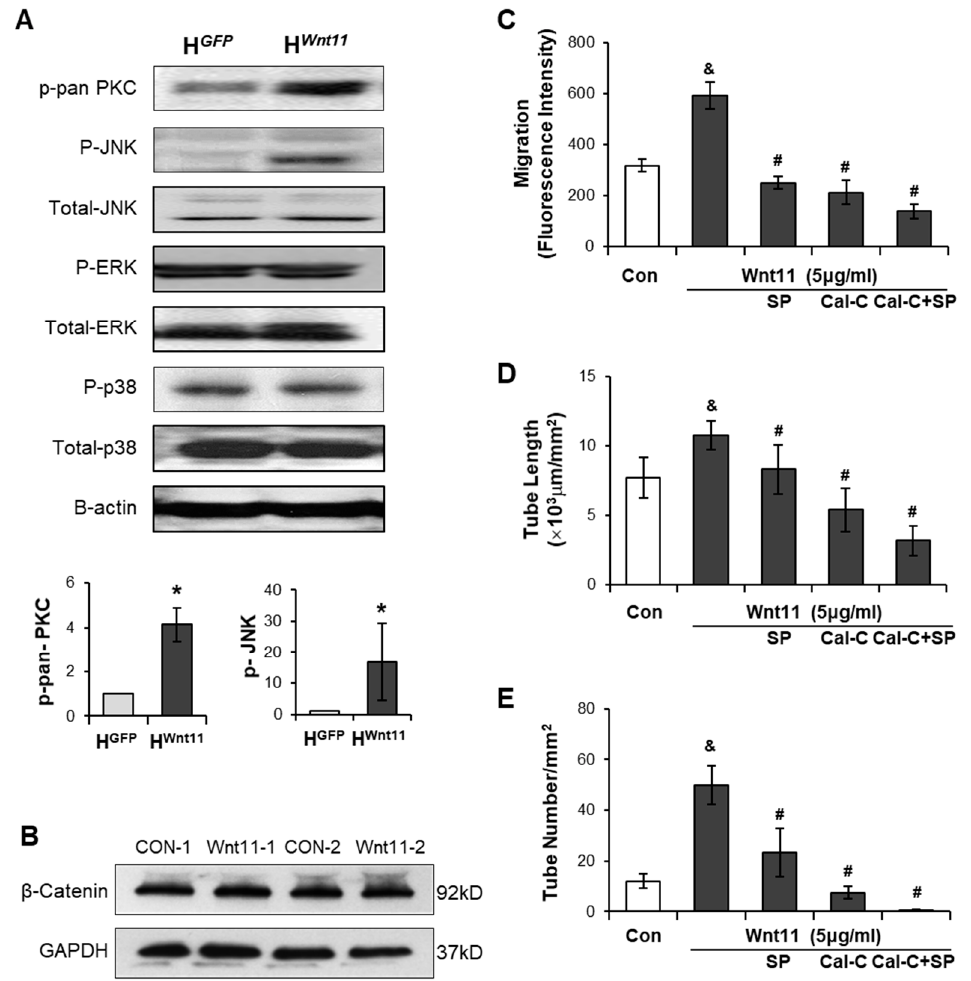
Figure 6. Wnt11 increases HUVEC migration and capillary-like tube (CLT) formations via activating PKC-JNK signaling pathway. ( A ): The protein levels of PKC / JNK signaling pathways in HUVECs were evaluated using Western blot and the relative protein density of p-pan-PKC and p-JNK in H Wnt11 , compared to those in H GFP . ( B ): β -catenin levels in HUVECs treated with / without Wnt11 (5 µ g / mL) for 24 h. ( C ): CLT length; ( D ): tube number; and ( E ): HUVEC migration was calculated under different treatment conditions. *, p < 0.05 vs. H GFP ; & , p < 0.05 vs. Control; # , p < 0.05 vs. Wnt11, respectively.